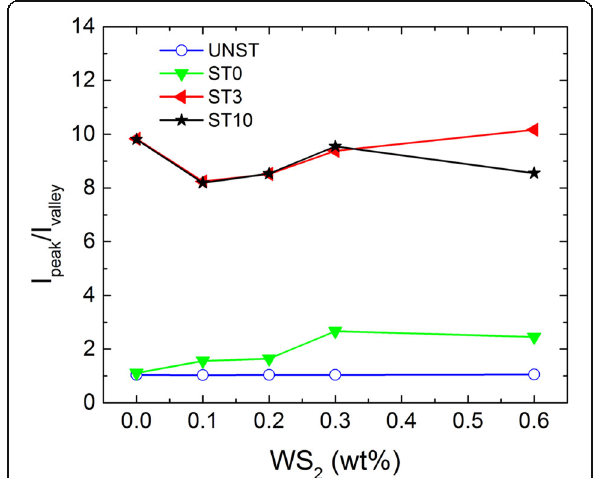
Fig. 5 Ratio of the intensity value of the main PLA reflection ( (110)/ (200), centered at q = 1.16 Å − 1 ) and the intensity value at the valley (positioned at q = 1.25 Å − 1 ) I peak /I valley for the UNST, ST0, ST3 and